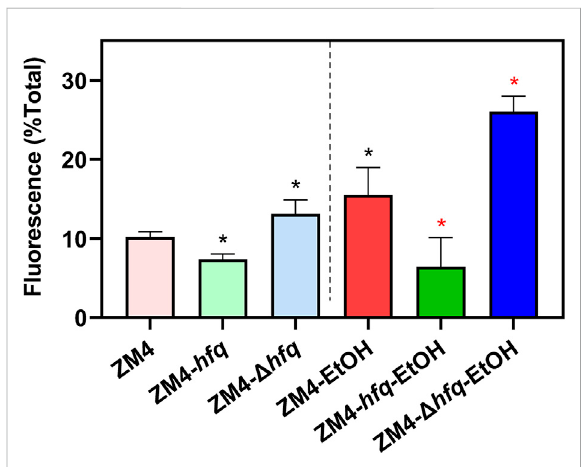
FIGURE 4 The effect of Hfq overexpression on reactive oxygen species (ROS) accumulation induced by ethanol in Z. mobilis . Z. mobilis strainswerecultured inMMmedia withorwithout 3%(v/v)ethanol treatment, and EtOH represents the ethanol treatment. One- way ANOVA analysis was conducted for ROS detection with ZM4 (black asterisk, p -value < 0.05) or ZM4-EtOH (red asterisk, p -value < 0.05) condition as the